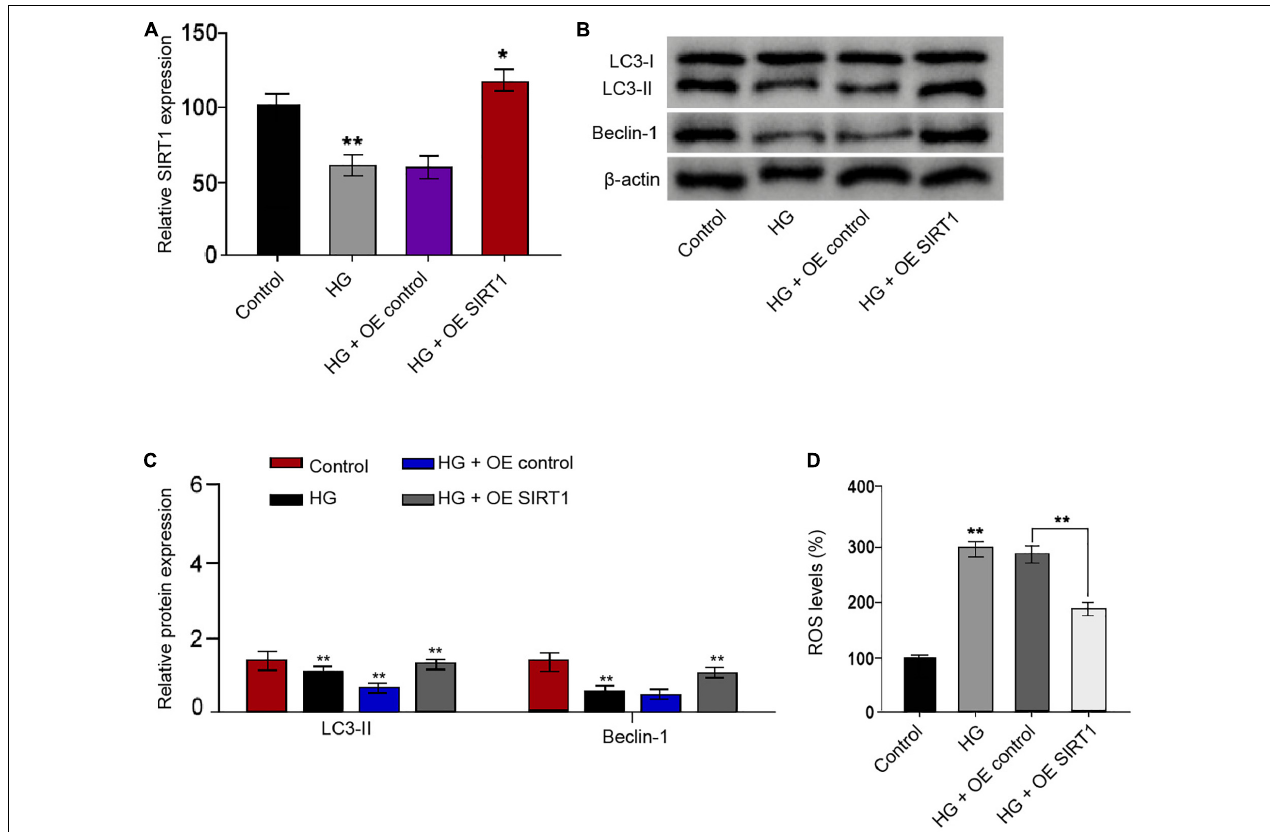
FIGURE 7 | SIRT1 induces autophagy and inhibits oxidative stress in the HG-treated Schwann cells. (A–D) The RSC96 cells are treated with HG, or co-treated with HG and pcDNA-3.1-SIRT1 overexpression vectors. (A) The expression of SIRT1 is examined by qPCR assays. (B,C) The expression of LC3I, LC3II, and Beclin-1 is assessed by Western blot analysis. (D) DCFH–DA staining shows the ROS production. N = 3, mean ± SD, * P < 0.05, ** P <